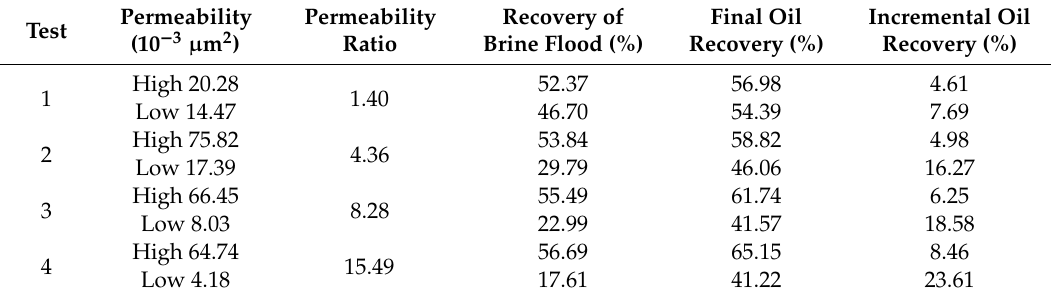
Table 1. Efficiency of enhanced oil recovery (EOR) in heterogeneous parallel cores. Table 1. E ffi ciency of enhanced oil recovery (EOR) in heterogeneous parallel